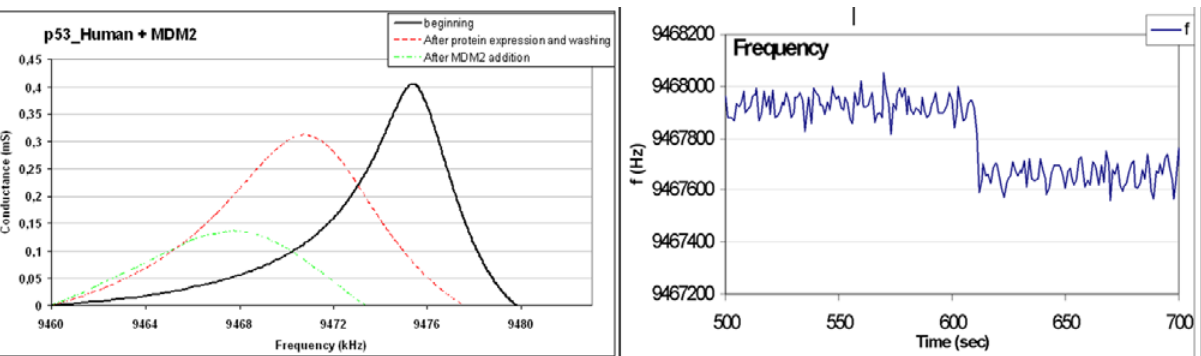
Figure 7. ( Left ) p53 quartz impedance curves recorded before the gene expression (solid curve), after the protein expression and the washing process (dashed curve) and after MDM2 addition (dotted curve); ( Right ) p53 quartz frequency variation in real time; at time t = 600 s a MDM2 solution (50 μ M in PBS) was injected in the flow chamber.